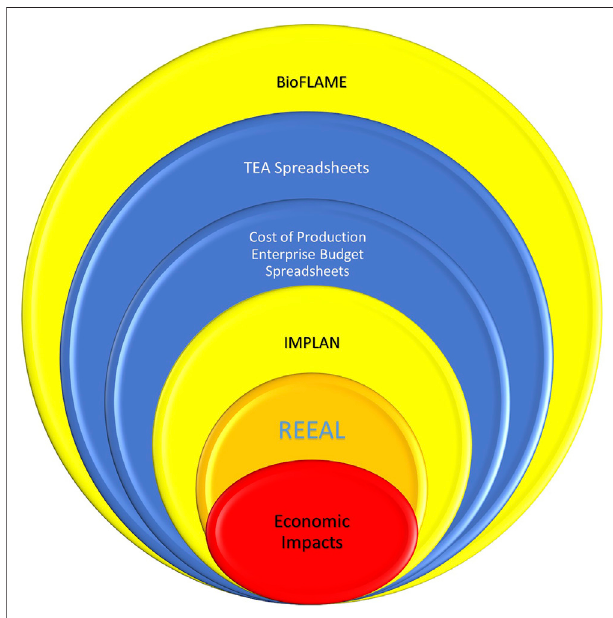
FIGURE 1 | Renewable energy economic analysis layers (REEAL) modeling system and its components.